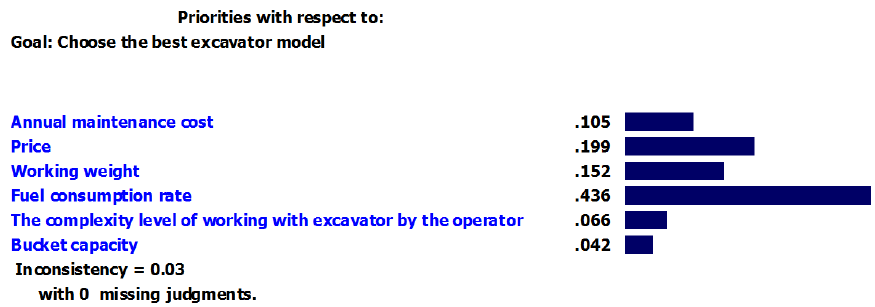
Fig. 3. Results of expert choice software to calculate the relative weights of criteria.